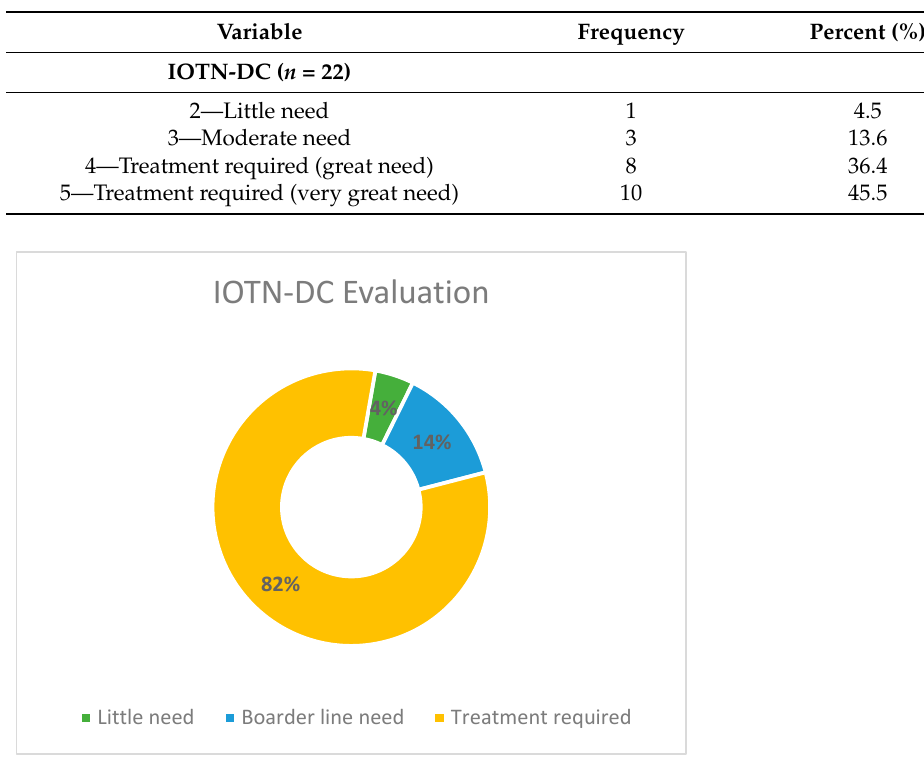
Figure 5. Distribution of the sample of children based on IOTN-DC Evaluation.